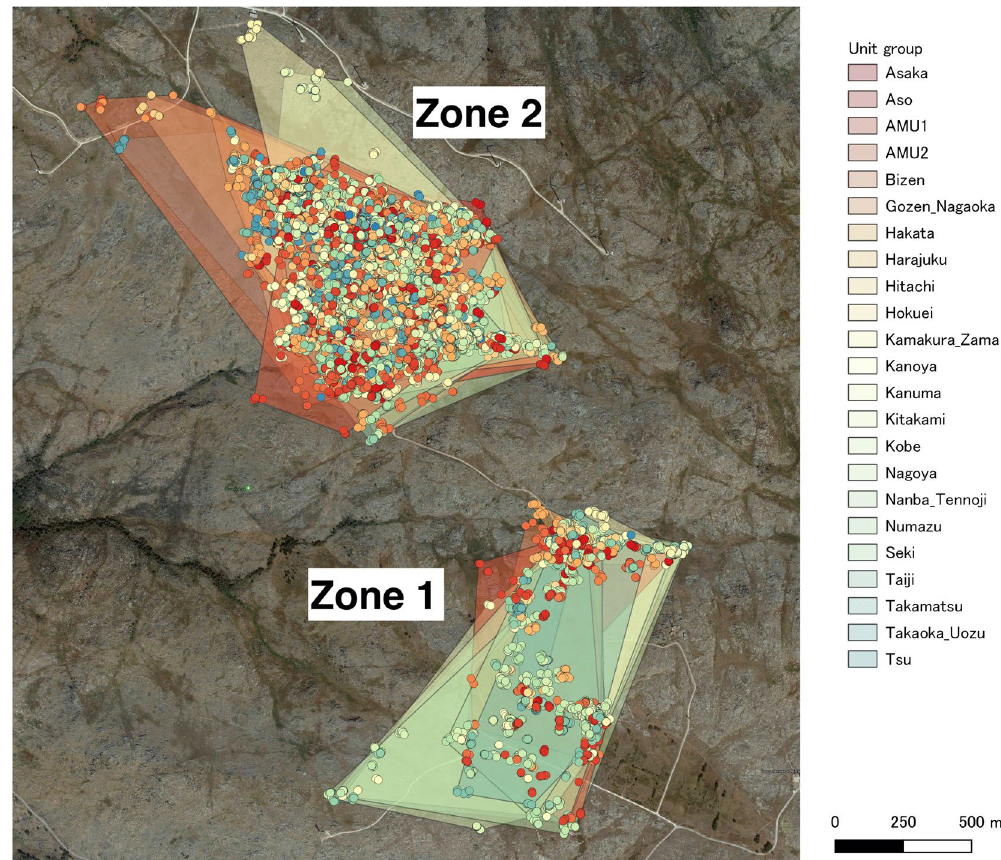
Figure 3. Observed horse position and the convex hulls that surrounds all of the observed positions of each unit. Each unit has different colour dots and convex hulls. The image was created under QGIS 3.6 environment (https ://qgis.org/ja/site/index